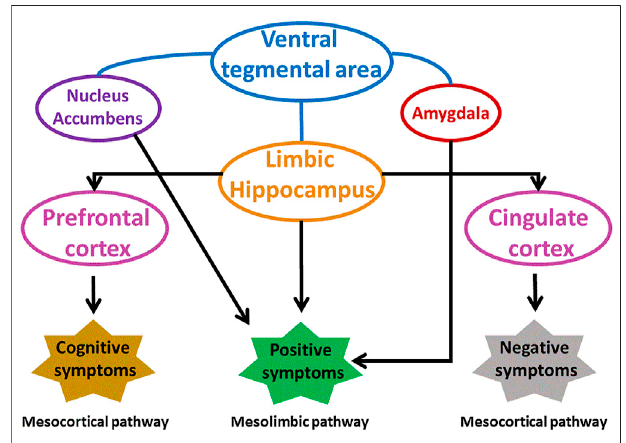
FIGURE 3 | Involvement of different brain areas in pathophysiology of schizophrenia. Modi fi ed from (Grace and Gomes 2019). VP, ventral